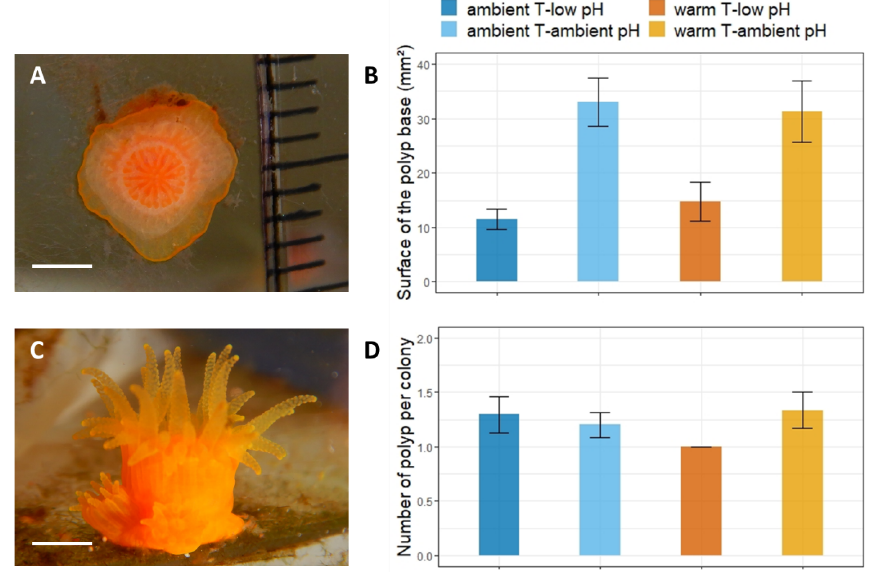
Figure 3. Mean surface of the recruits’ base and mean number of polyps per colony of A. calycularis under the two temperature treatments (23 ◦ C for ambient temperature and 26 ◦ C for warm temperature) and the two pH treatments (pH T = 8 . 05 ± 0 . 09 for ambient pH and pH T = 7 . 78 ± 0 . 10 for low pH) after 9 months. Values are means ± SE. (a) Picture of the base of a recruit through the glass of the crystallizer, (b) mean surface of the recruits’ base at 9 months old, (c) picture of a recruit with two new polyps on the outskirts, and (d) mean number of polyps per colony. The colors of the bars indicate the temperature and pH treatment. n = 9–20 per condition. Scale: